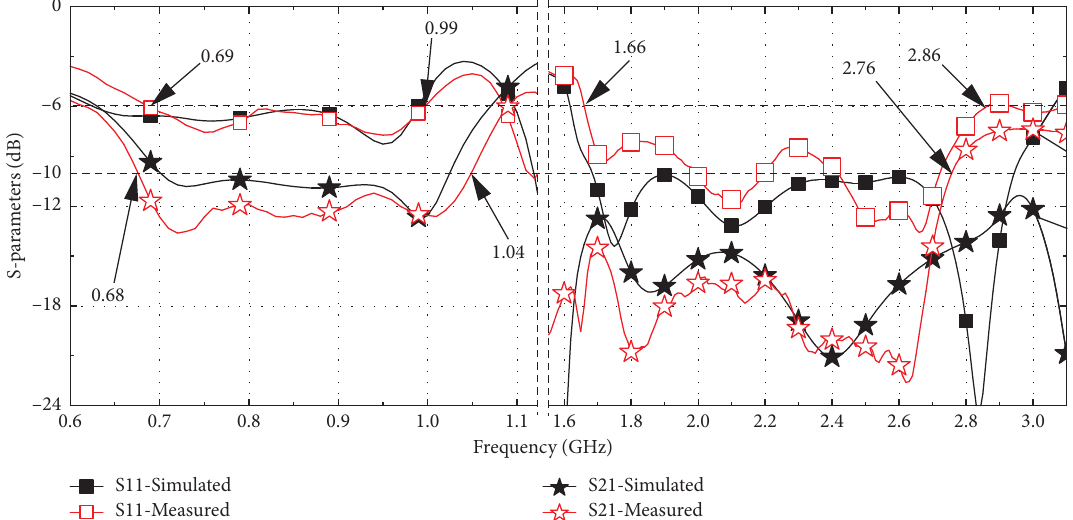
Figure 10: Simulated and measured S-parameters of the proposed